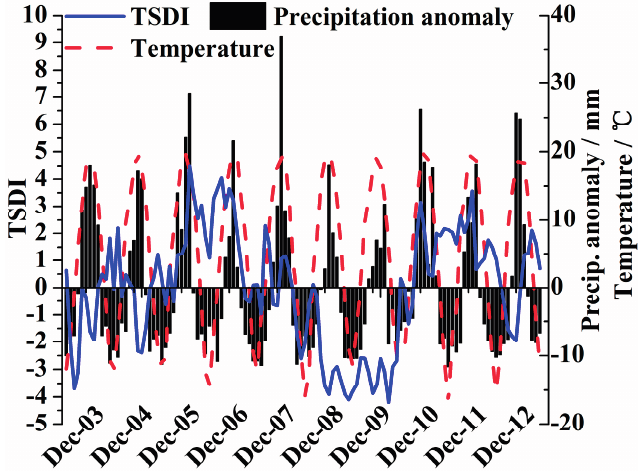
Figure 9. Total storage deficit index (TSDI) of the arid